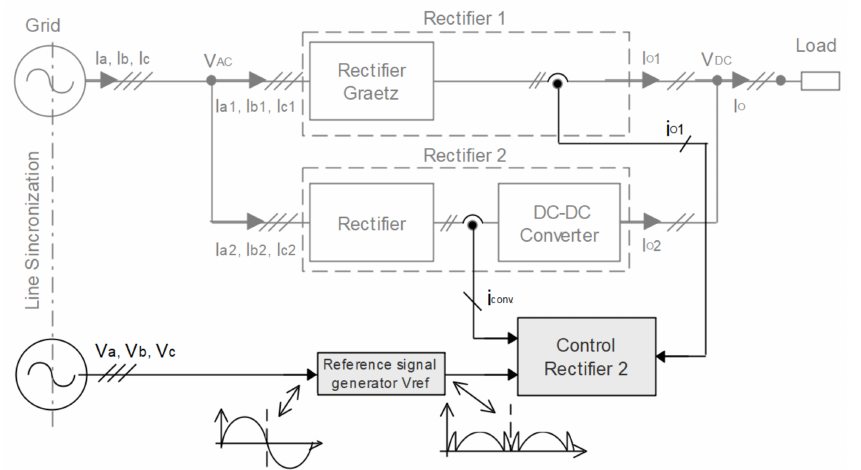
Figure 29. Configuration of electrical circuit applied in HTR with sinusoidal current, using a reference signal